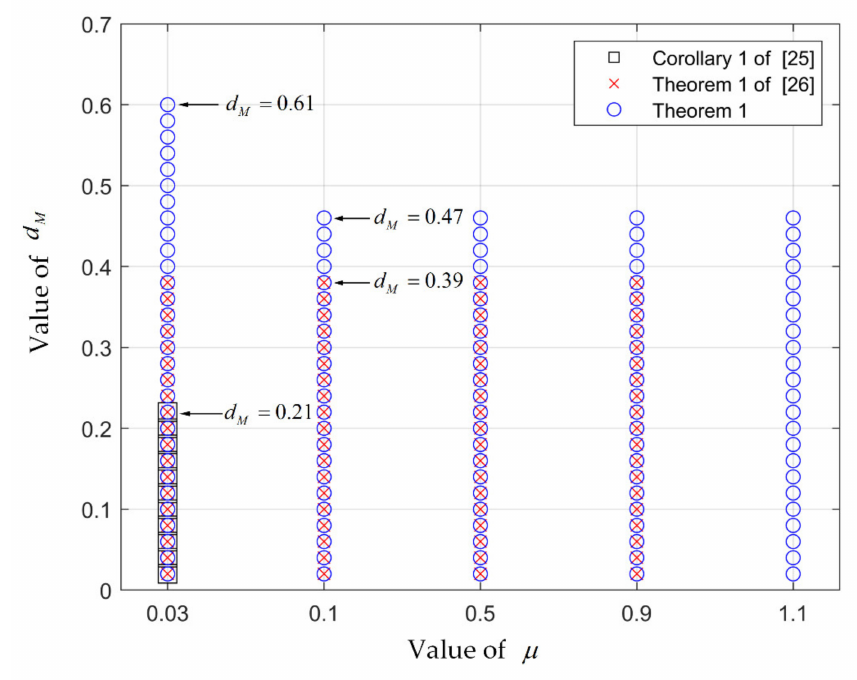
Figure 8. Comparison